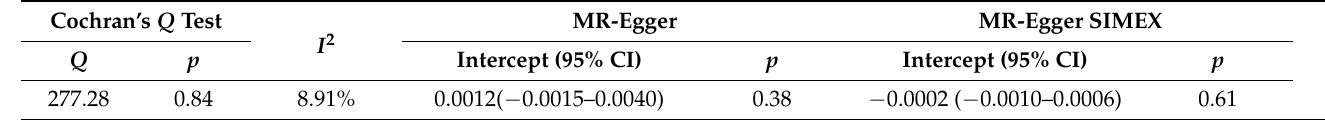
Table 2. The heterogeneity and pleiotropy tests of the instrumental